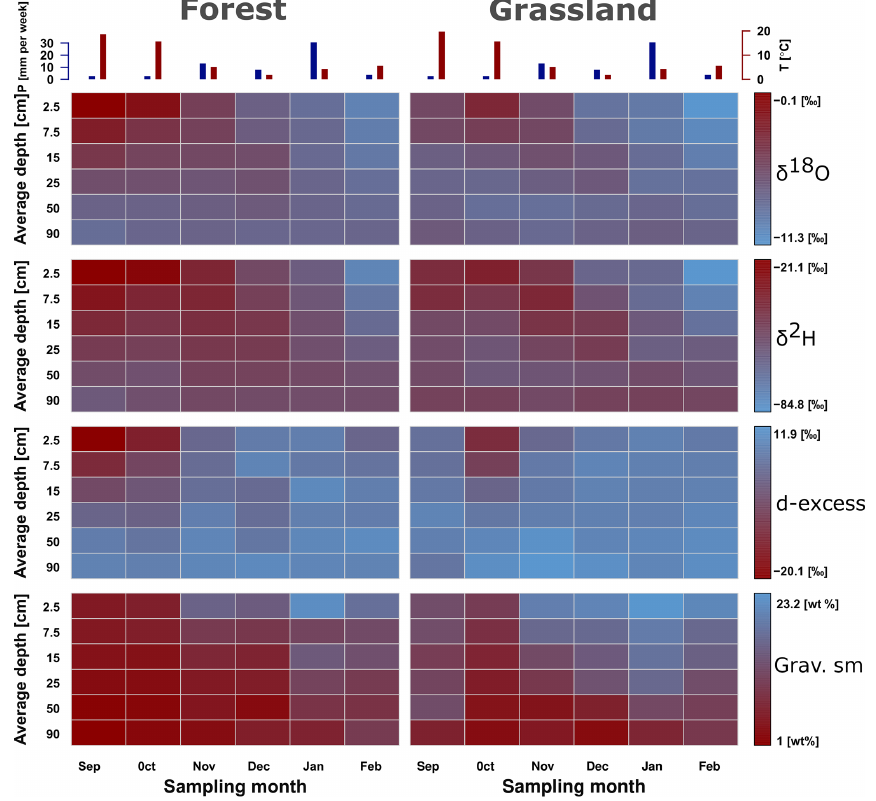
Figure 5. Heat map of soil depth profiles for mean δ 2 H, δ 18 O, d-excess and gravimetric (grav.) soil moisture of three replicates at both land use classes (forest and grassland) of six monthly sampling dates. Blue to red colours indicate more to less depleted δ 2 H and δ 18 O values, declining d-excess, and grav. soil moisture values. On top, antecedent conditions of mean daily air temperature and the sum of precipitation 7d prior to sampling are displayed in the bar chart.